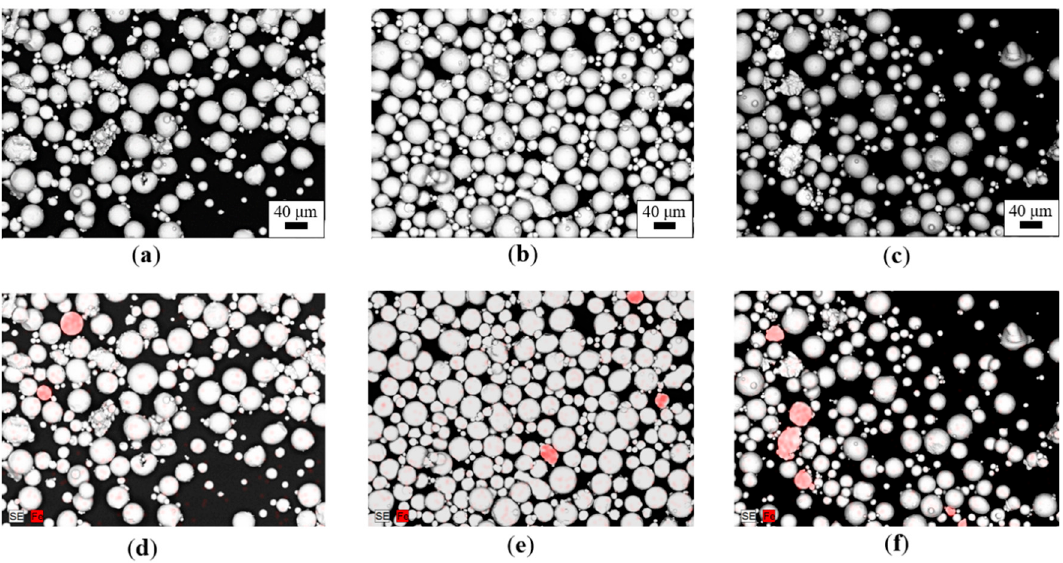
Figure 5. SEM–BSE micrographs of the Ti-based cross-contamination samples: ( a ) Ti64 + 0.5MS, ( b ) Ti64 + 1MS, ( c ) Ti64 + 2.5MS, and the respective EDS elemental maps: ( d ) Ti64 + 0.5MS, ( e ) Ti64 + 1MS, ( f ) Ti64 + 2.5MS. Red particles correspond to maraging steel.